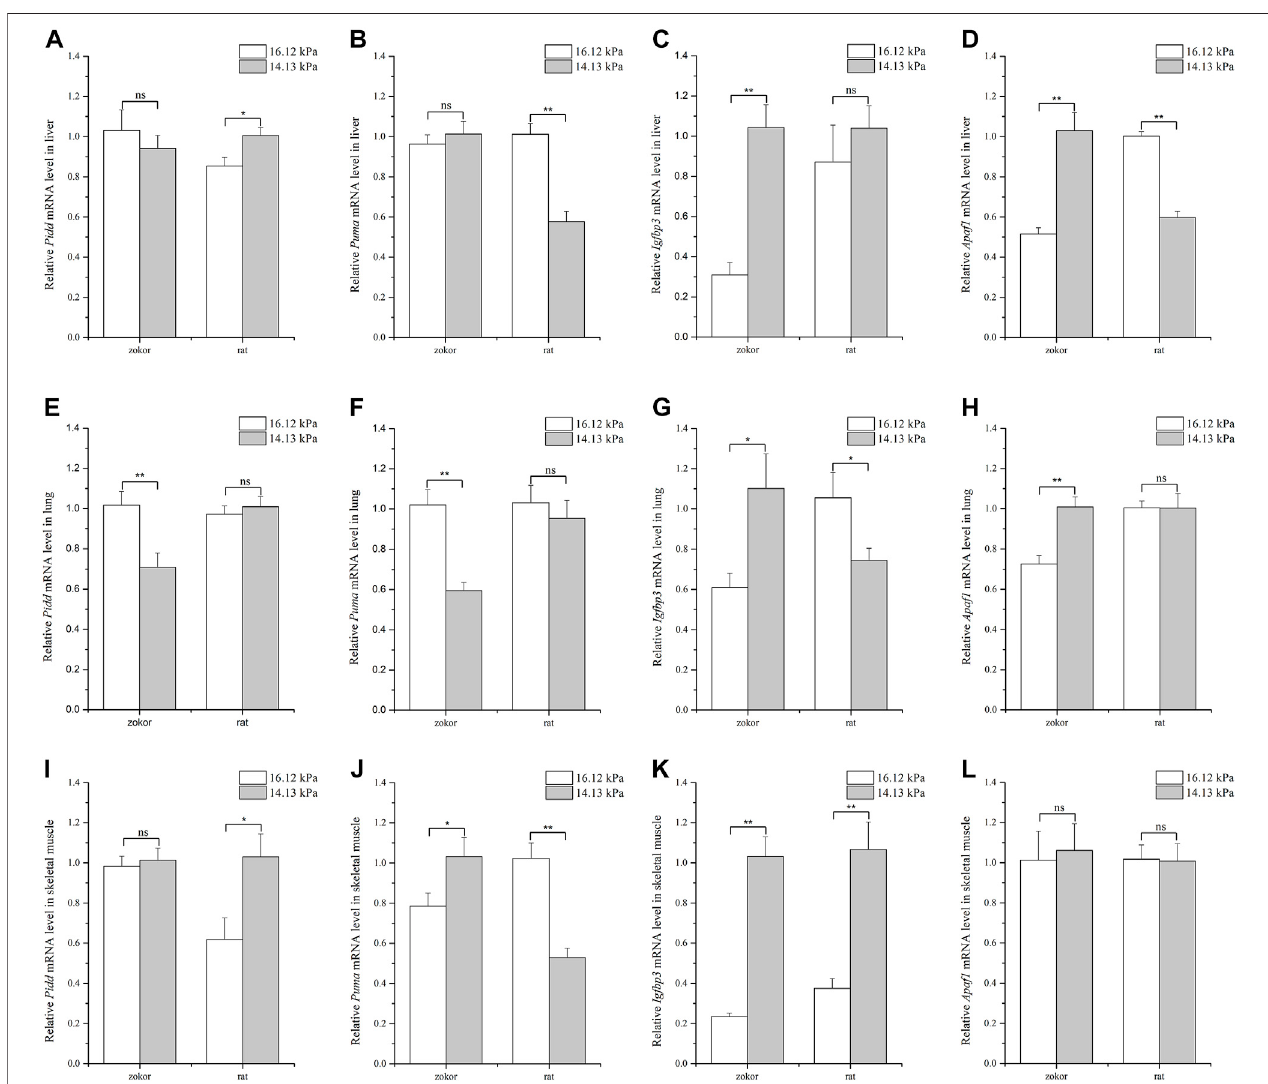
FIGURE 1 | Quanti fi cation of apoptosis-related genes mRNA levels in tissues of plateau zokor and Sprague – Dawley rat under different oxygen partial pressures. Panels indicate liver (A – D) , lung (E – H) , and skeletal muscle (I – L) . pp , p < 0.01; p , p < 0.05; ns, not signi fi cant ( p > 0.05). The sample size was eight for each group.